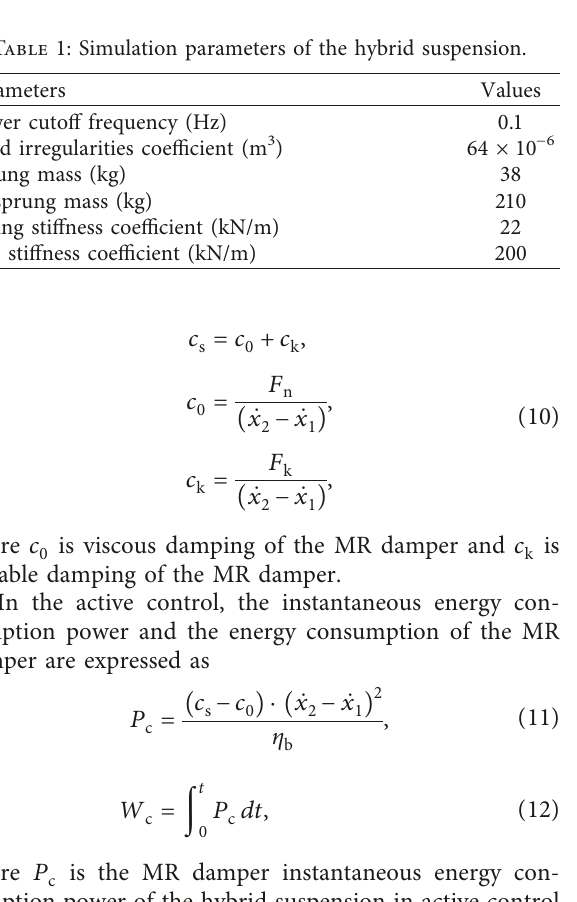
Figure 4: The damping force-velocity curves of the MR damper.